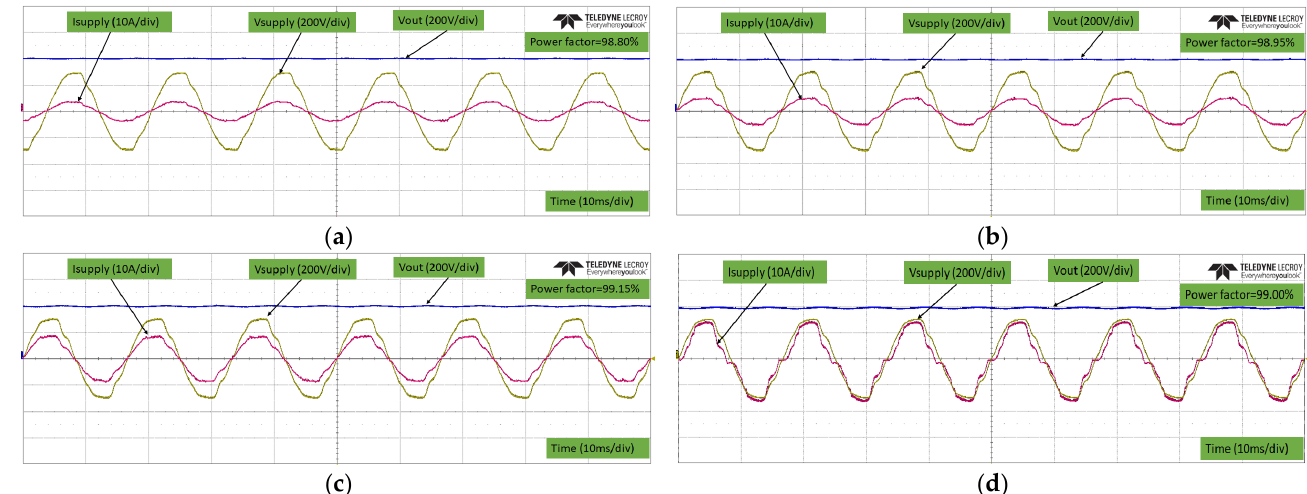
Figure 23. Experimental setup for testing of the designed PFC converters.